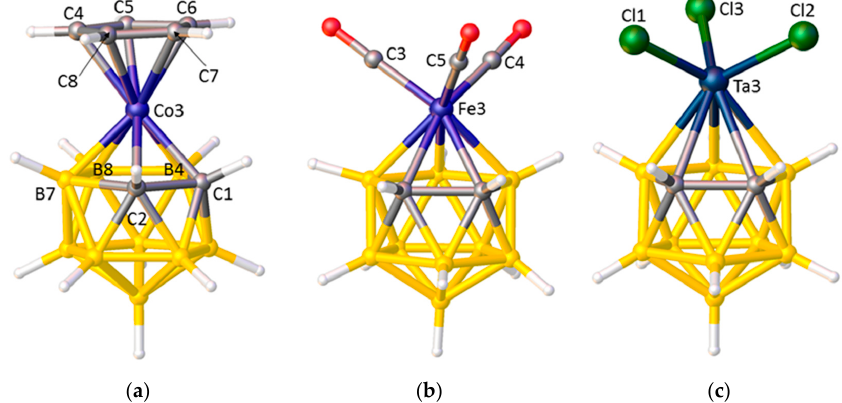
Figure 5. ( a ) The structure of [3-Cp- closo -3,1,2-CoC 2 B 9 H 11 ]. Co3 − C1 2.009(2), Co3 − C2 2.005(2), Co3 − B7 2.069(2), Co3 − B8 2.106(2), Co3 − B4 2.076(2), Co3 − C4 2.036(2), Co3 − C5 2.035(2), Co3 − C6 2.046(2), Co3 − C7 2.069(2), Co3 − C8 2.056(2) Å; ( b ) The structure of [3,3,3-(CO) 3 - closo -3,1,2-FeC 2 B 9 H 11 ]. Fe3 − C3(| θ | = 113.2°) 1.792(9), Fe3 − C4(| θ | = 135.9°) 1.777(9), Fe3 − C5(| θ | = 12.9°) 1.804(11) Å; ( c ) The structure of [3,3,3-Cl 3 - closo -3,1,2-TaC 2 B 9 H 11 ]. Ta3 − Cl(| θ | = 50.9°) 2.259(5), Ta3 − Cl2(| θ | = 63.1°) 2.233(5), Ta3 − Cl3(| θ | = 172.1°) 2.205(5) Å.